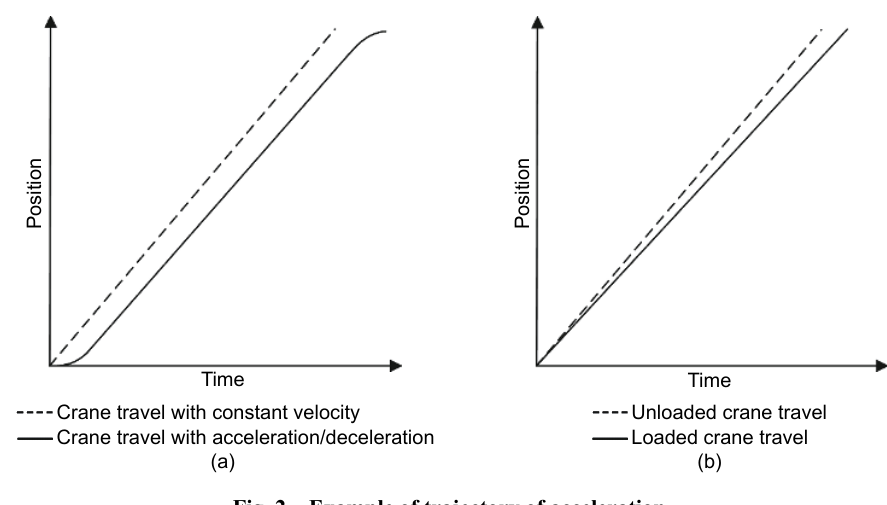
Fig. 2 Example of trajectory of acceleration.